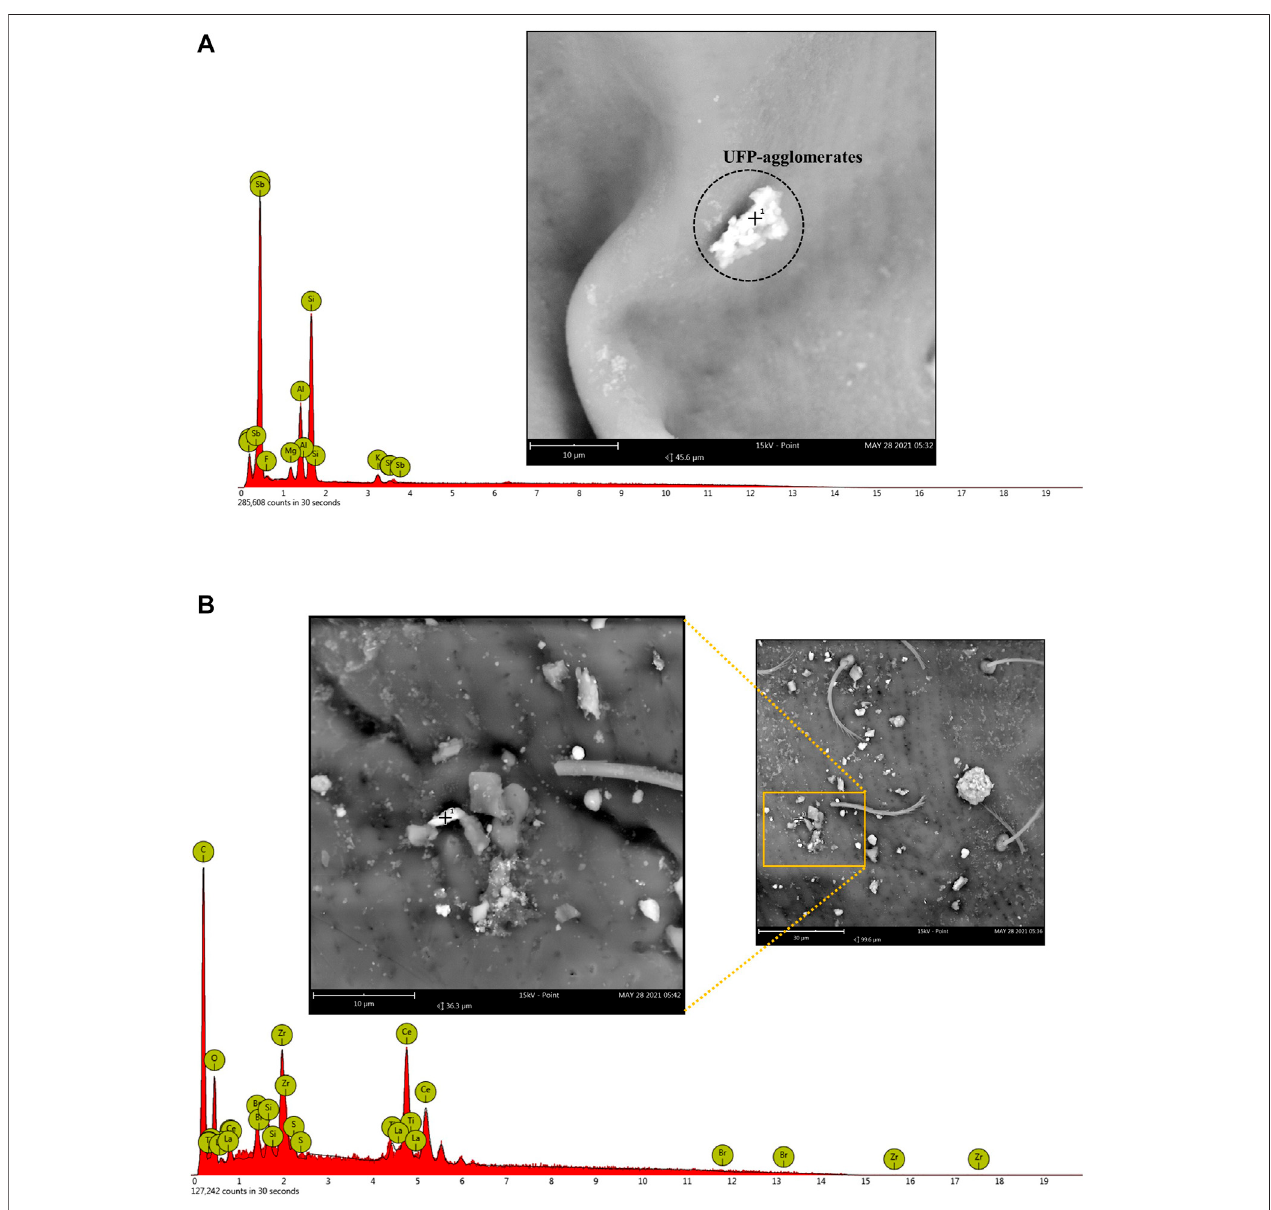
FIGURE 5 | Scanning electron microscopy images and energy dispersive spectroscopy analysis of (A) UFP agglomerates on Hannemania mites, and (B) semiquantitative analysis of UFP.